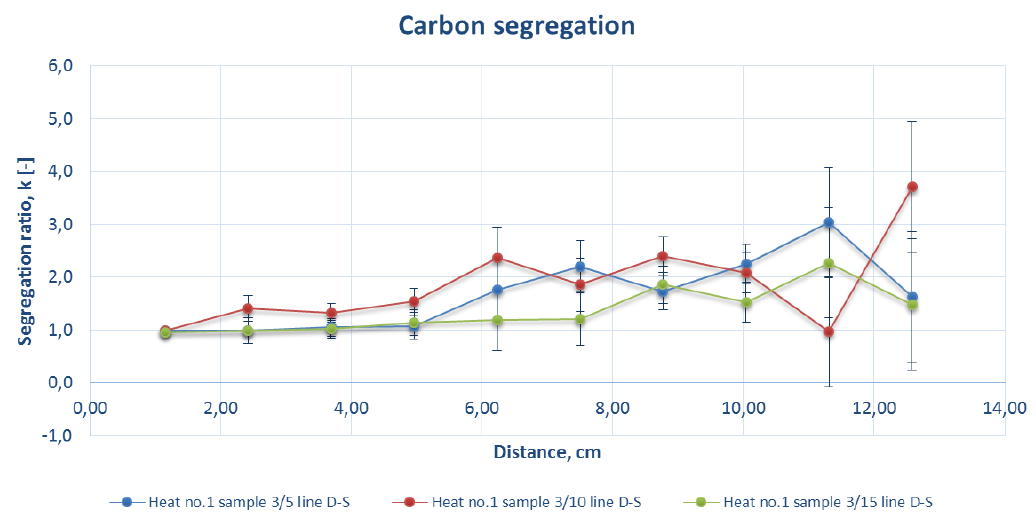
Figure 8. Comparison of the carbon segregation ratio for the sample DS line of strand 3 at a casting speed of 1.8 m/min (heat number 1).